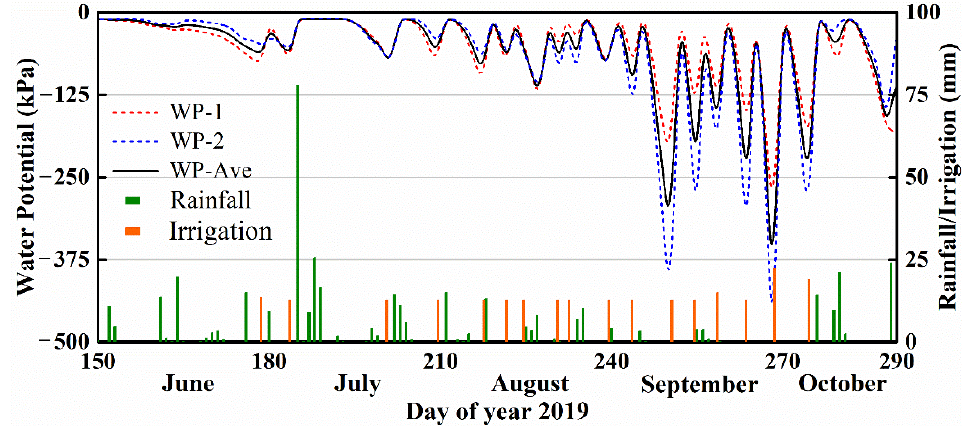
Figure 5. Illustration of daily based irrigation, rainfall events and soil water potential at different depths. ent